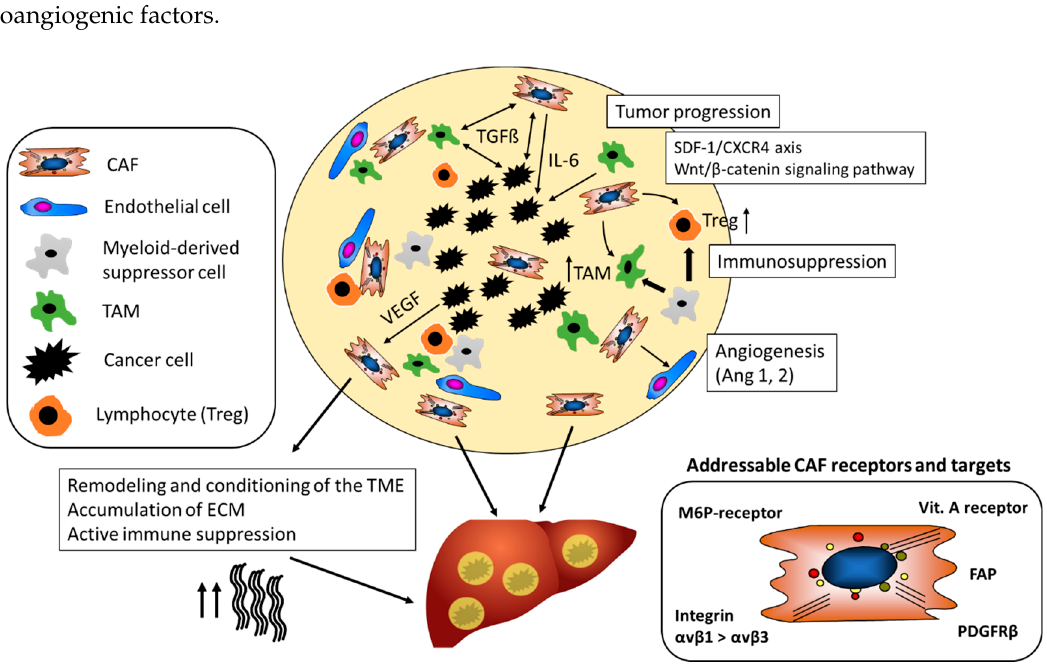
Figure 2. The tumor-promoting role of CAF in the TME. CAF maintain a tolerogenic character of the TME and promote the differentiation of regulatory T-cells (Treg) and tumor-associated-macrophages (TAM). They support tumor neovascularization by stabilizing vessels via secretion of, for example, Ang-1. CAF mediated alterations of the ECM contribute to resistance to chemotherapeutics and checkpoint inhibitors and support tumor growth and metastasis. Different CAF receptors and targets have been identified for cell-specific drug delivery (Ang-1, Angiotensin-1; CAF, Cancer-associated fibroblasts; CXCR4, chemokine receptor type 4; FAP; ECM, extra-cellular matrix; Fibroblast activation protein; PDGFR β , platelet-derived growth factor beta; M6P-receptor, mannose-6-phosphate receptor; SDF-1, stromal cell-derived factor 1; TGF β 1, transforming growth factor beta 1; VEGF, Vascular endothelial growth factor).